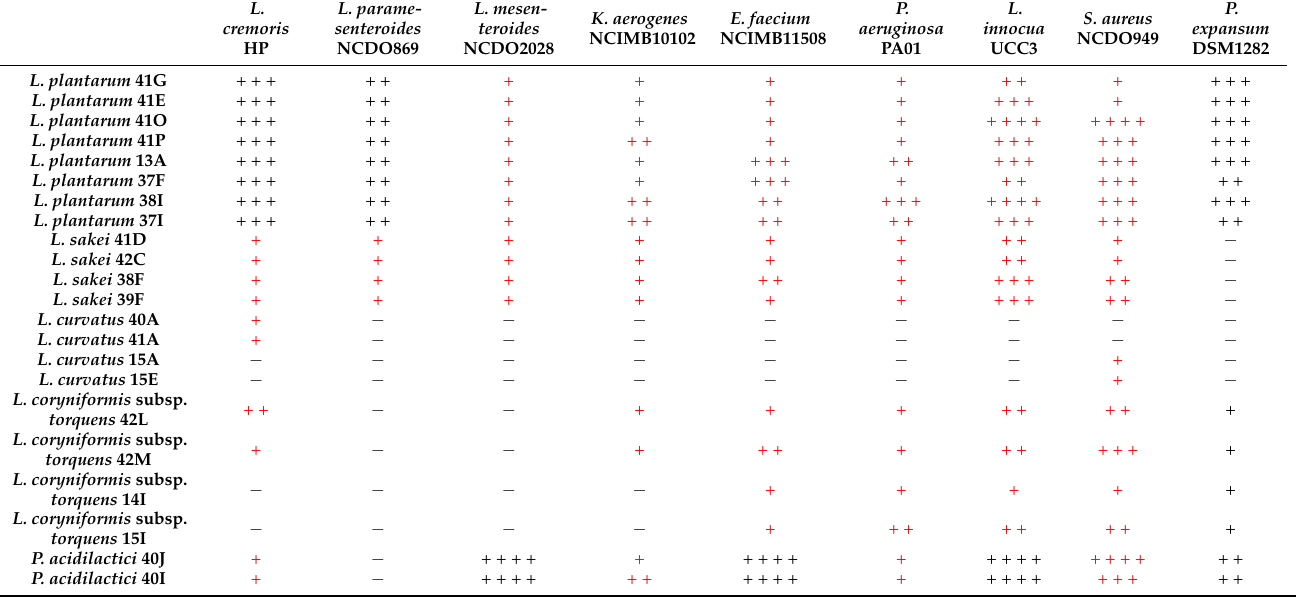
Table 1. Spot-on-lawn antimicrobial and antifungal assays of LAB isolates against a range of indicators: L. cremoris HP; L. paramesenteroides NCDO869; L. mesenteroides NCDO2028; K. aerogenes NCIMB10102; E. faecium NCIMB11508; P. aeruginosa PA01; L. innocua UCC3; S. aureus NCDO949; and fungal strain P. expansum DSM1282. + = zone of inhibition present (color-coded red if the zone of inhibition against bacteria indicators looked hazy); − = no zone of